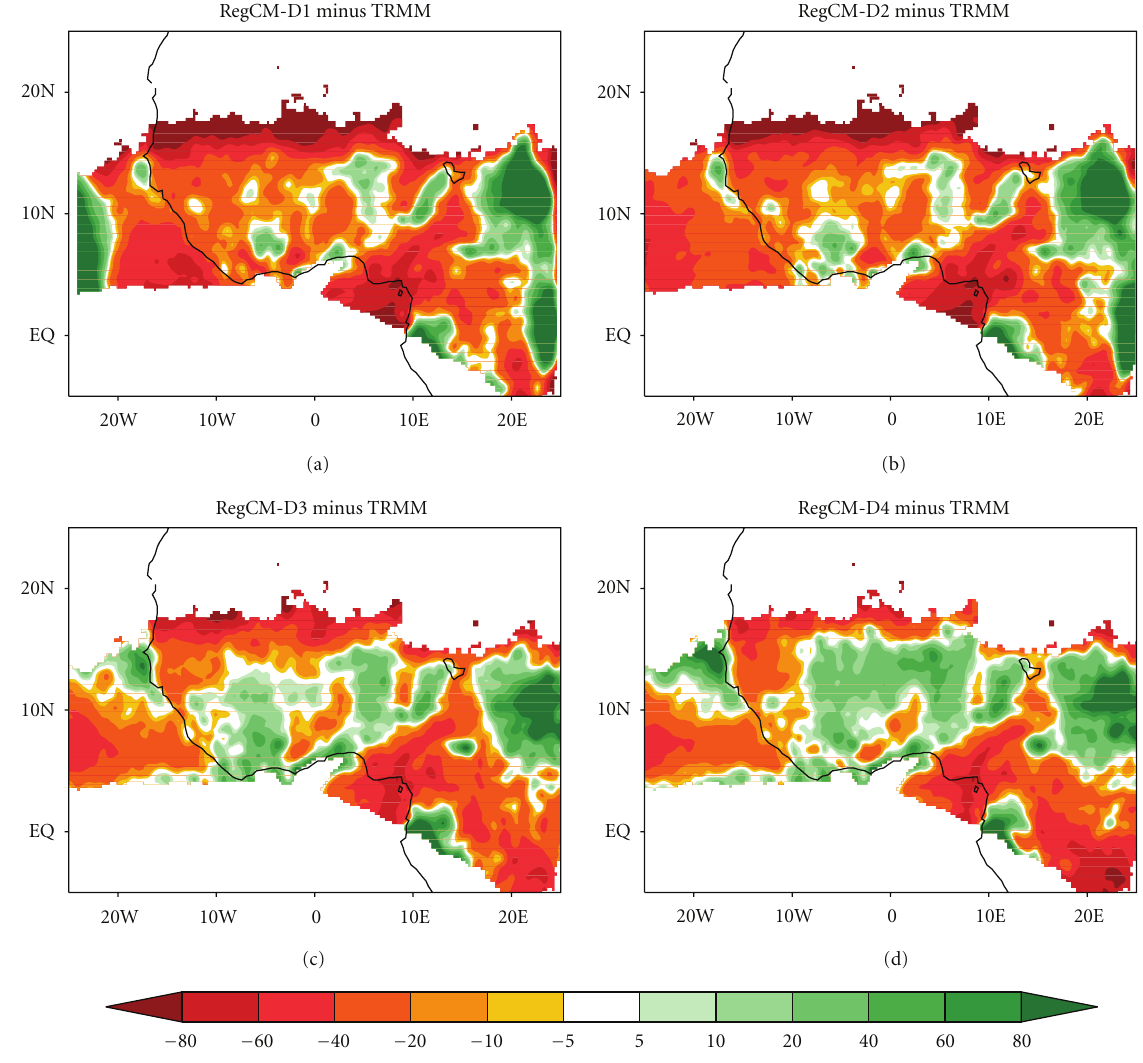
Figure 3: Di ff erences in mean JJA rainfall between (a) RegCM-D1 and TRMM, (b) RegCM-D2 and TRMM, (c) RegCM-D3 and TRMM and (d) RegCM-D4, and TRMM. Units are expressed as percentage of TRMM values.